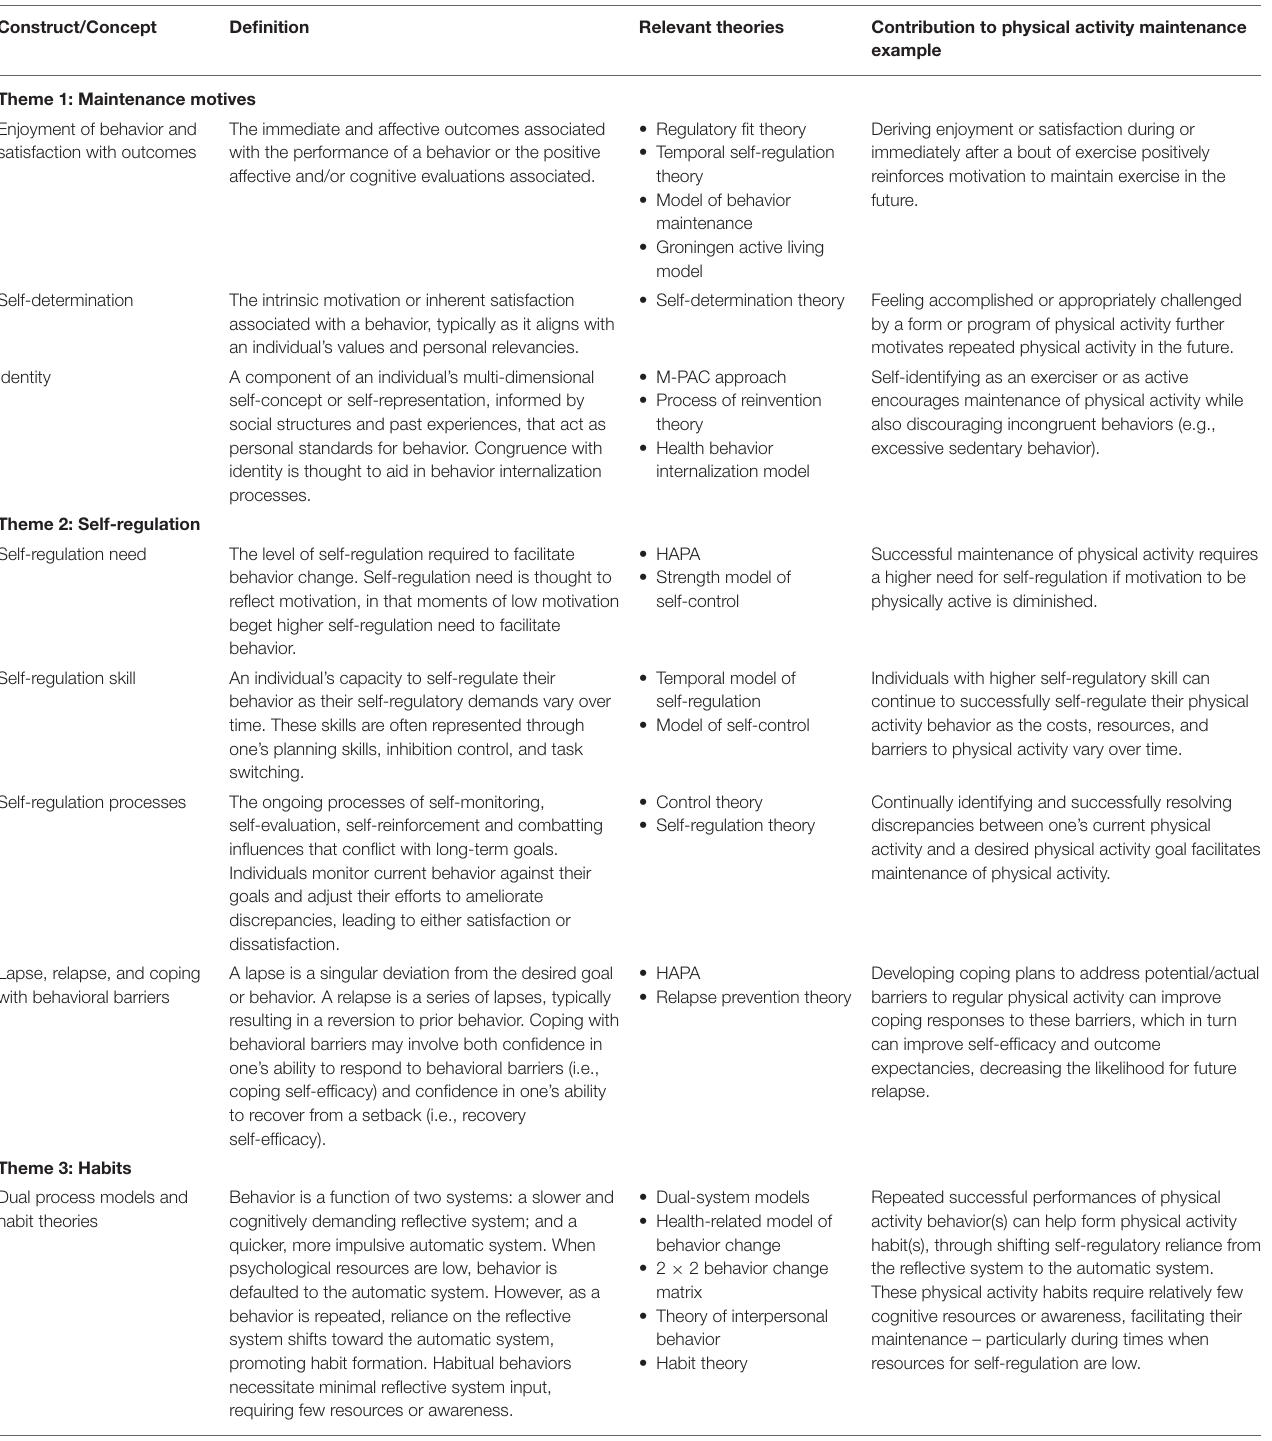
TABLE 2 | Construct and concepts associated with physical activity